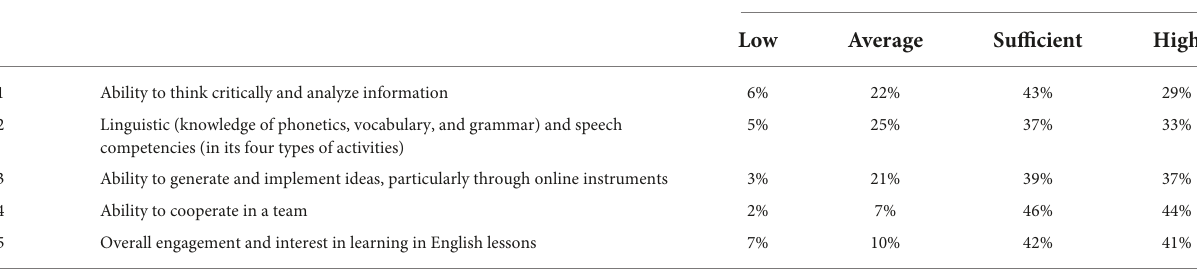
Low Average Sufficient High